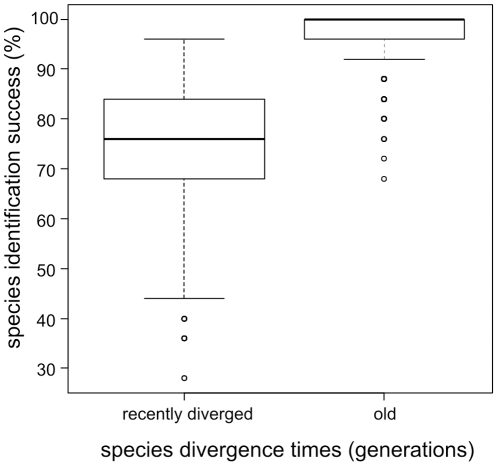
Influence of species divergence on species identification success.Boxplots of percent species identification success (N = 300) based on query data sets for species that were either recently diverged (divergence times between 98 and 76621 generations) or old (divergence times between 76621 and 553116 generations).